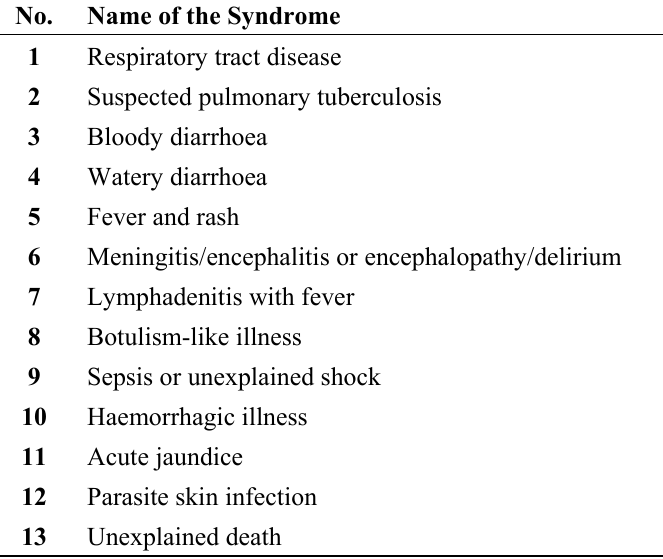
Table 1. List of the 13 syndromes under